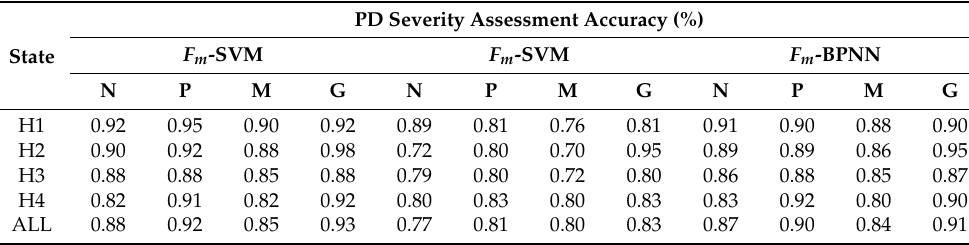
Table 8. Assessment feature subsets in descending order under M, P, and G class